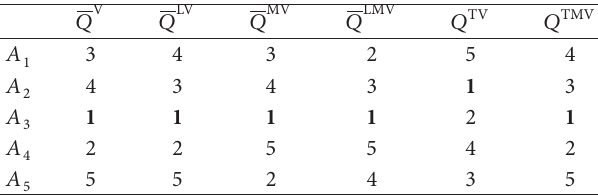
Table 16: Final ranking.